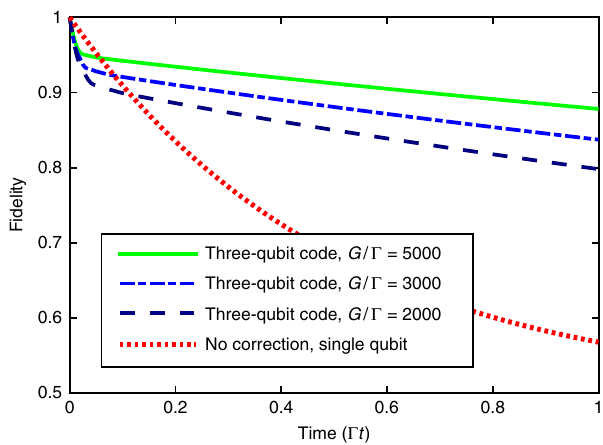
Fig. 5 Continuous error correction of a three-qubit code against spin- fl ip noise compared to single-qubit decay. We simulate the dynamics of a system of three physical qubits subjected to individual spin- fl ip errors at a rate Γ under the action of the error correction scheme by simulating the full master equation _ ρ ð t Þ restricted to at most one excitation. The shown results are obtained from optimizing the fi delity (see main text) at t = 1/ Γ by the choice of κ eng and Ω for each considered value of the sideband coupling G . For comparison, the red dotted line displays the decay of a single qubit subject to spin- fl ips at a rate Γ . We fi nd that the implementation of our scheme in trapped ions leads to a signi fi cantly reduced decay: Assuming a sideband coupling of G = 5000 Γ (green solid line), a fi delity of F ≈ 0.9 of the dissipatively protected logical qubit (encoded in three decaying physical qubits) is maintained after a time t (cid:4) 1 = ffiffiffi p Þ G such that neither of the reside at energies Δ 2 ; ± (cid:7) ð 1 ± 2